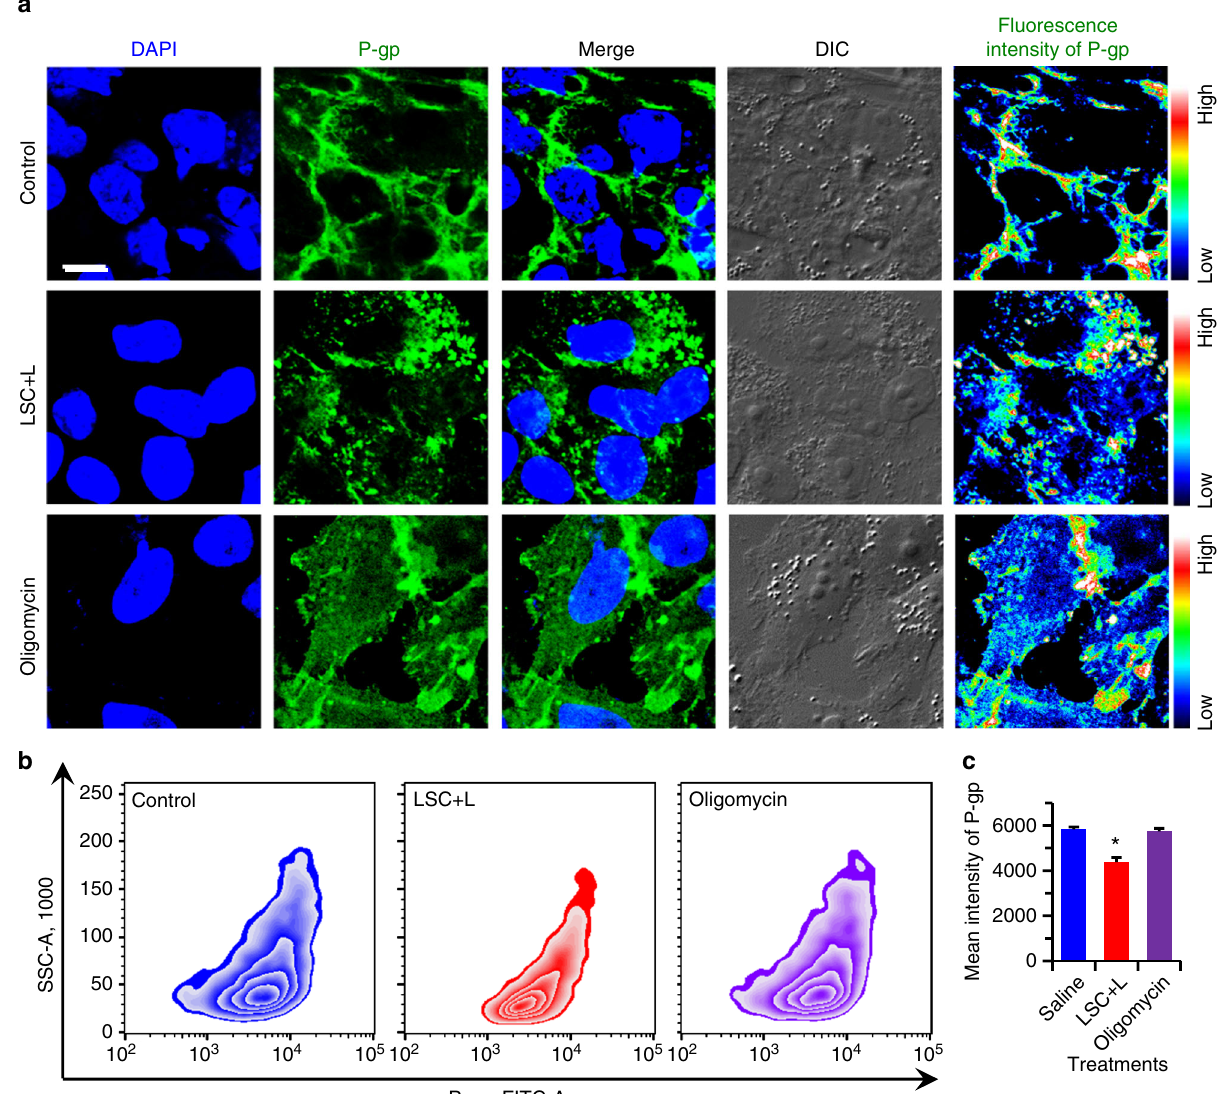
Fig. 4 Overcoming drug resistance by reducing the amount and changing the distribution of P-gp. a Confocal images and fl uorescence intensity of P-gp in NCI/RES-ADR multidrug-resistant cancer cells without any treatment (control) and after treated with LSC nanoparticles with laser irradiation (LSC + L, 1 W cm − 2 for 1 min). The data show that the P-gp distributes not only on the cell plasma membrane but also in the cytoplasm after the LSC + L treatment, whereas it is dominantly located on the plasma membrane for the cells in the control group. In order to con fi rm the changed distribution of P-gp is owing to the inhibition of ATP, the multidrug-resistant cancer cells were treated with oligomycin (an inhibitor of ATP synthase) for 12 h at 200 ng ml − 1 , the results con fi rm that inhibition of ATP can in fl uence the distribution of P-gp. Scale bar: 10 μ m. b – c Flow cytometry analysis of P-gp and quantitative data show that the expression of P-gp is slightly but signi fi cantly decreased in the multidrug-resistant cancer cells with the LSC + L treatment. These data indicate that multiple mechanisms contribute to the capability of the LSC + L treatment in overcoming the drug resistance of the multidrug-resistant cancer cells. The cells were permeabilized for the immunostaining and fl ow cytometry analyses. Error bars represent s.d. ( n = 3). * p < 0.05 (Kruskal – Wallis H cells after treatment with LSC nanoparticles. The isolated dysfunctional. In order to understand how long the LSC membrane proteins were mixed with ATP to determine whether nanoparticle and laser treatment can inhibit the function of the the ef fl ux pumps were active. As shown in Fig. 3f, the membrane ef fl ux pumps, we incubated NCI/RES-ADR cells with free DOX proteins from cells treated with either LSC nanoparticles or NIR for 3 h at 1 – 5 days after LSC + L treatment. As shown in irradiation alone do not consume any ATP. In contrast, ATP is Supplementary Fig. 33, free DOX can enter the cells even after consumed by the membrane proteins from LSC + L-treated cells. 5 days although the fl uorescence intensity of DOX in the cells This indicates the ef fl ux pumps in LSC + L-treated cells are not gradually decreases with longer waiting time. These data indicate bound with ATP. If the ef fl ux pumps in NCI/RES-ADR cells are that the multidrug resistance of NCI/RES-ADR cells can be inactive, free DOX should be able to enter the cells and bind with successfully overcome by targeted production of ROS in their the cell nuclei. Indeed, DOX is observed in both 2D-cultured mitochondria using a combination of LSC nanoparticles and NIR NCI/RES-ADR cells and their spheres after LSC + L treatment laser irradiation. This opens a therapeutic window of at least (Supplementary Fig. 32), con fi rming that ef fl ux pumps become 5 days for chemotherapy.